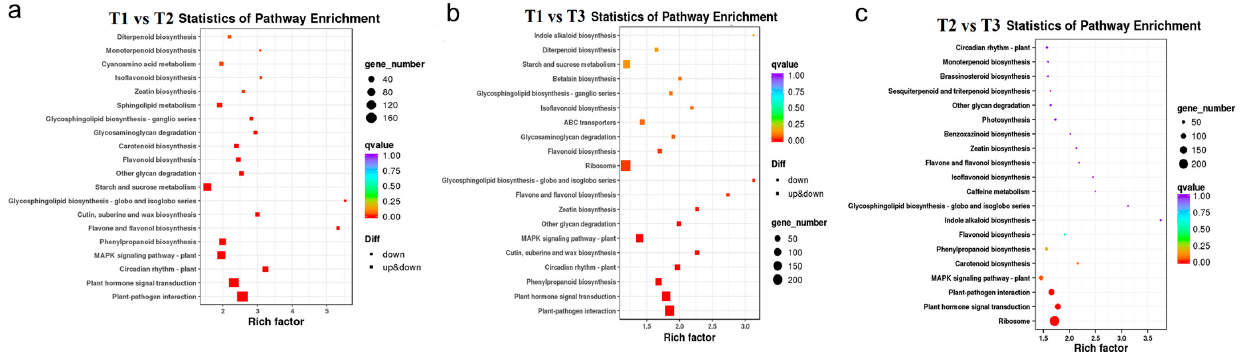
Figure 7. KEGG pathway enrichment of differently expressed genes (DEGs). ( a ) T1 vs. T2 comparison group; ( b ) T1 vs. T3 comparison group; ( c ) T2 vs. T3 comparison group. Diff represents differentially expressed genes. Down and up & down represents downregulated genes and upregulated or downregulated genes,